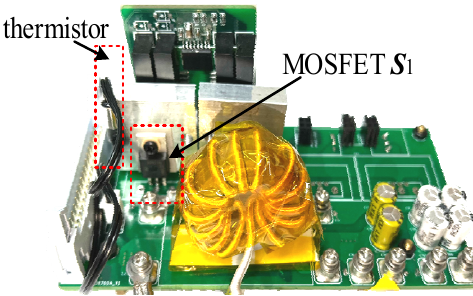
OTC method and the output voltage PI control.